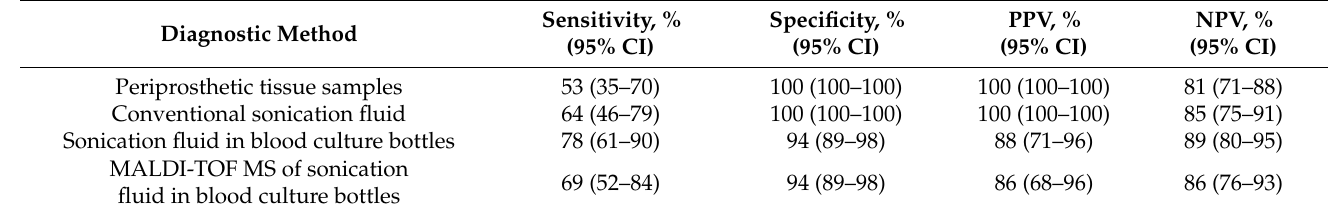
Table 2. Diagnostic performance of three diagnostic methods in 107 patients with removed prosthesis (36 with prosthetic joint infection and 71 with aseptic failure).